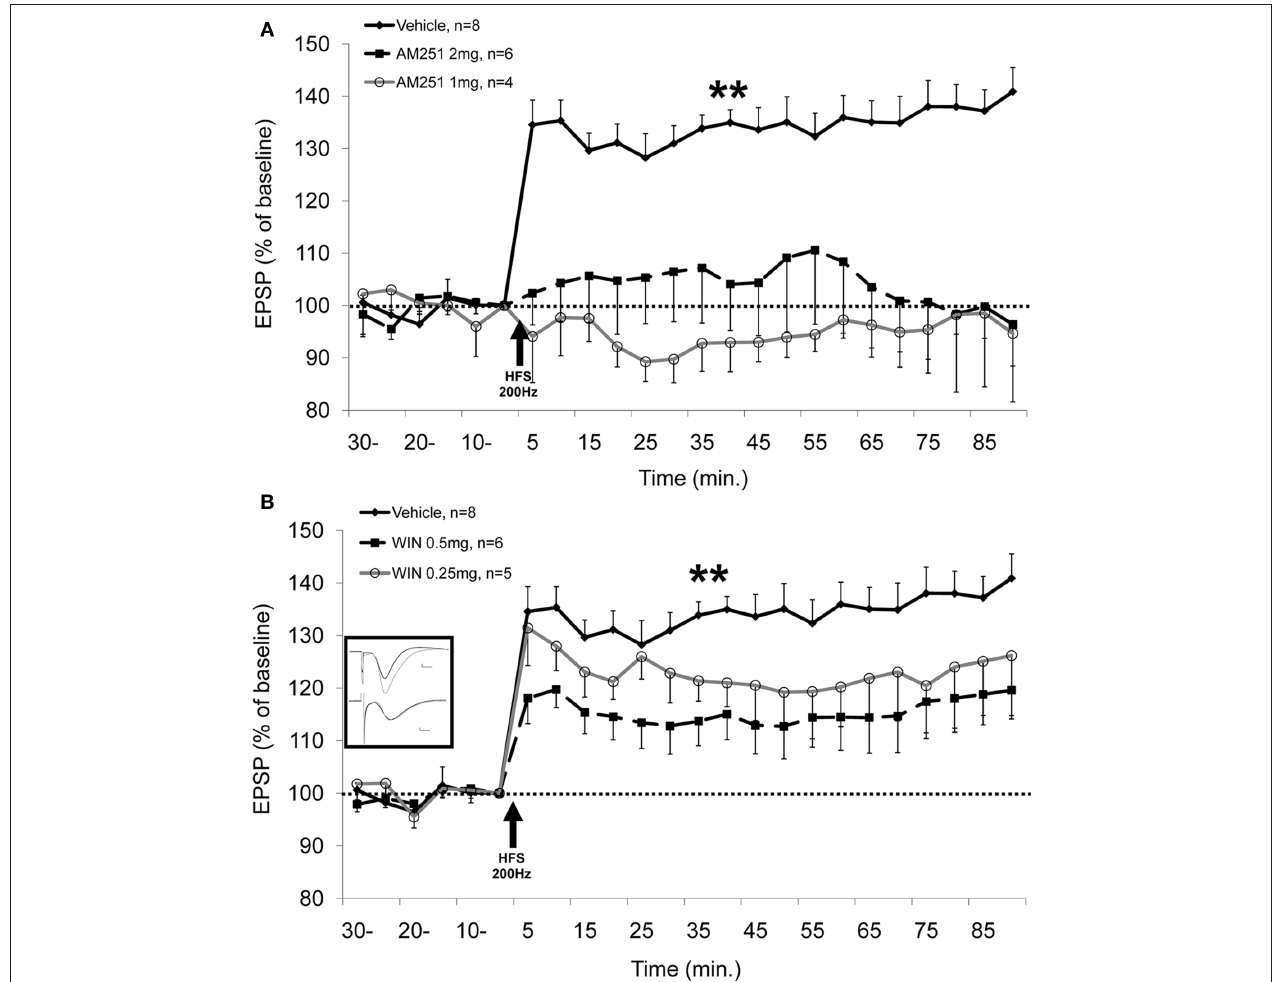
to the Schaffer collateral significantly impairs the induction of LTP in the CA1 compared with the vehicle group ( P < 0.01). No significant difference is observed between the groups before HFS. Inset: representative traces in the CA1 for vehicle (upper traces) and WIN 0.5 mg (lower traces) groups taken before (black) and 90 min after (gray) HFS to the Schaffer collateral (calibration: 0.2 mV, 10 μs). Data published by Abush and Akirav (2010) in Hippocampus